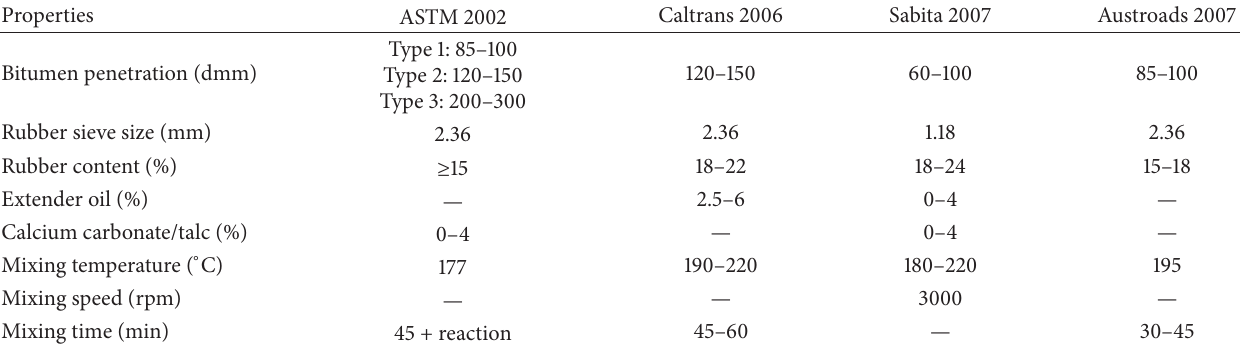
Table 1: Important parameters in manufacturing CRMB according to several specifications around the world (adopted from